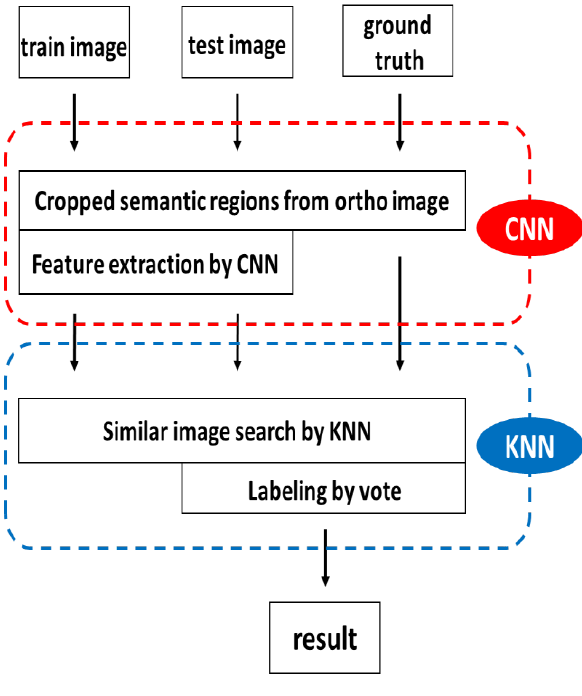
Figure 1. The overview of our method.